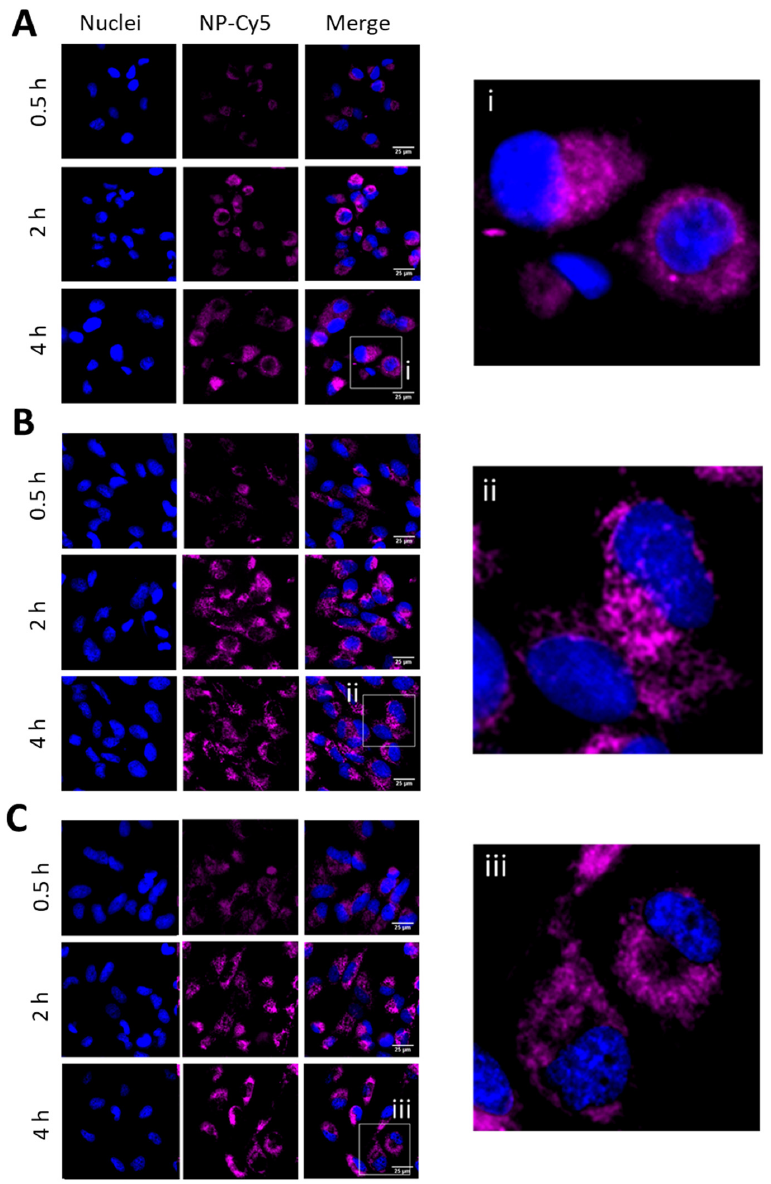
Figure 4. Uptake characteristics of Cy5-NP P2 in GBM cells. ( A – C ) Fluorescent micrographs of nanoparticle internalisation in ( A ) U87, ( B ) GIN28 and ( C ) GIN8 cells. Cells were incubated with nanoparticle solution at concentration of 50 µg/mL for 0.5, 2 and 4 h. (i, ii, iii) Enlarged areas highlighted by white boxes. Scale bar = 20 µm. Images are representative of three independent experiments.